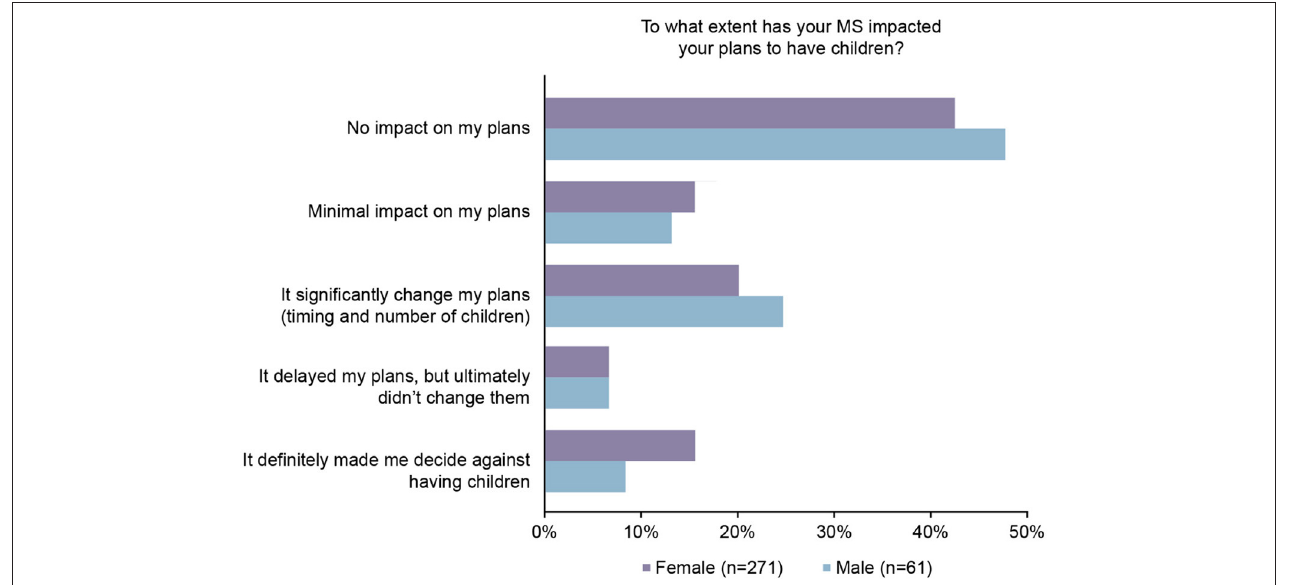
FIGURE 4 | Patients who were significantly impacted by multiple sclerosis (MS) on having children, by gender.